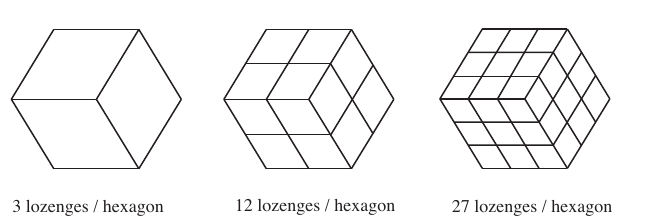
Figure 1: Lozenge submesh and its associated refinement in the hexagonal geometry.